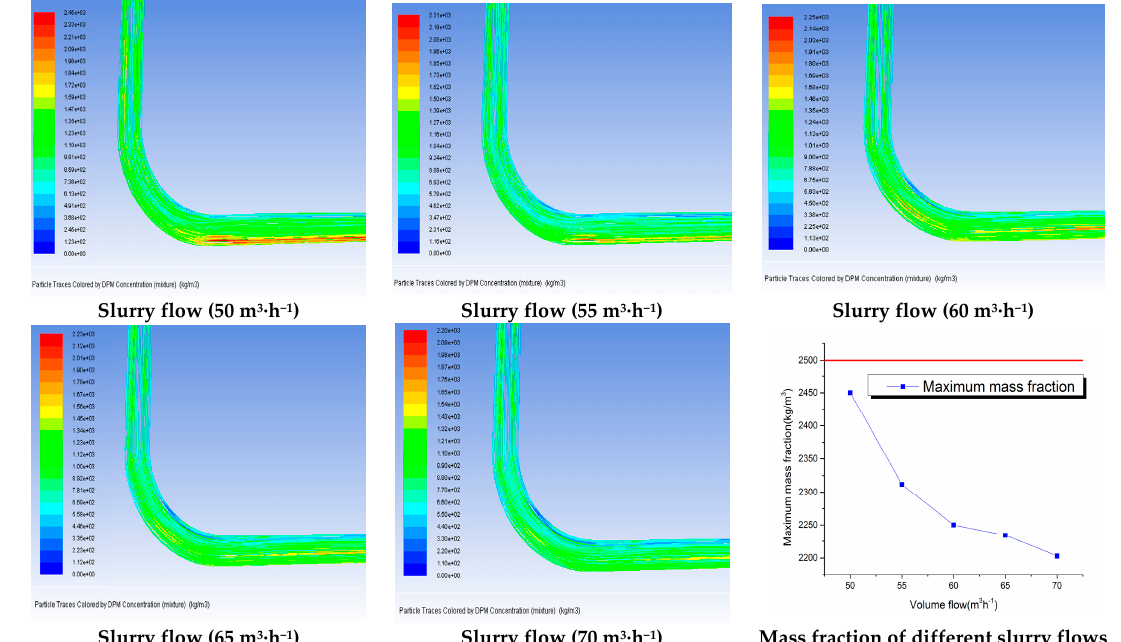
Figure 10. Distribution of discrete phase mass fraction.